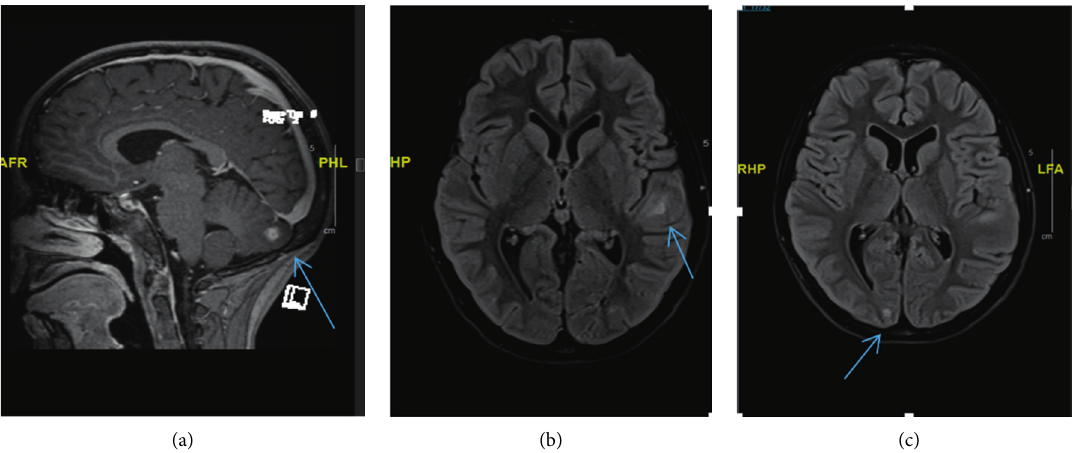
Figure 3: Transverse and sagittal magnetic resonance T1 contrast images of the brain show multiple tuberculomas; each appears as a ring- enhancing lesion with a hypointense center surrounded by a hyperintense area (edema). One lesion is at the left cerebellar hemisphere (a). Other small foci are at the left temporal gyrus (b) and right occipital lobe